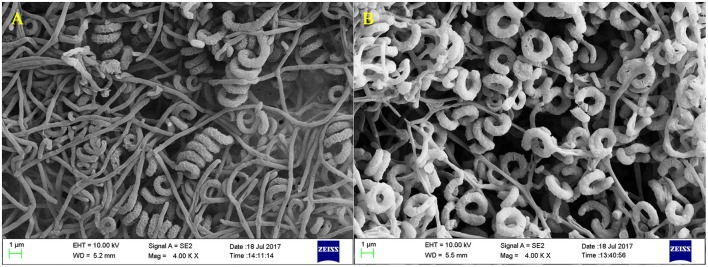
Scanning electron microscope images of Streptomyces sp. CB-75. Morphological characters of aerial mycelia (A) and spores (B) of Streptomyces sp. CB-75 viewed using SEM.